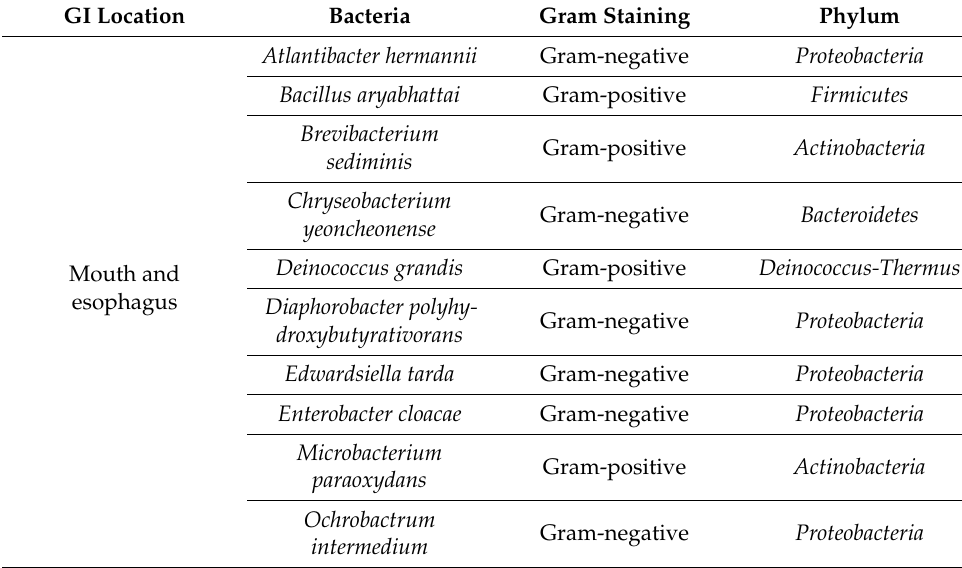
Table 1. Bacteria isolated from different locations of the gastrointestinal tract of C. porosus . Bacteria were isolated from the gastrointestinal tract of C. porosus and based on the color, shape, texture and size, different bacteria colonies were cultured separately until pure culture were obtained, which were eventually subjected to 16S rDNA sequencing for